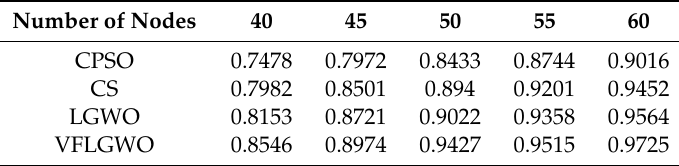
Table 6. Coverage rate with different numbers of sensor nodes.